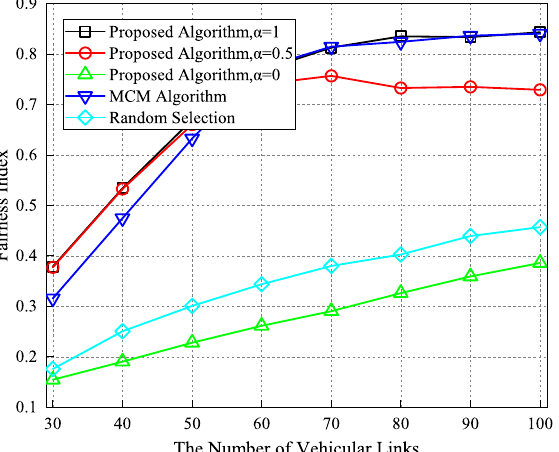
Figure 9. The fairness performances of different schemes with varying V2V links.